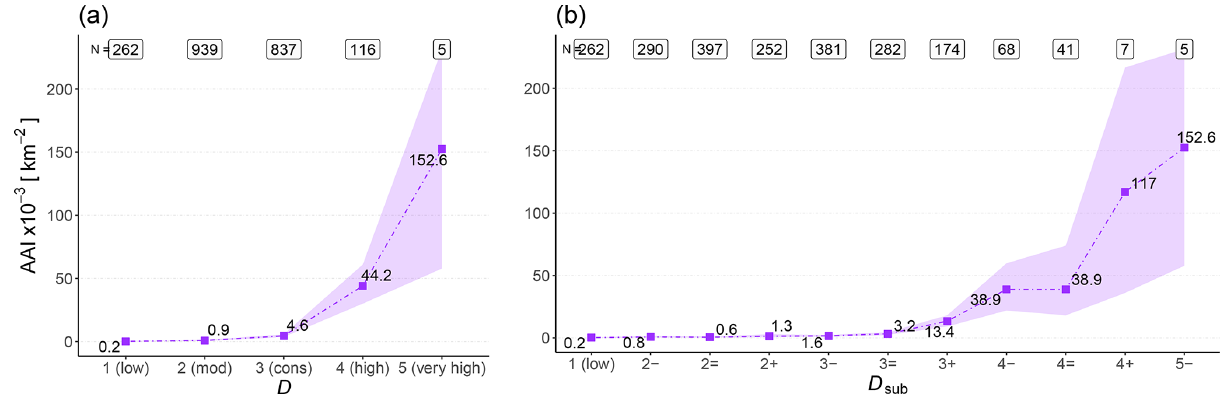
Figure 6. Avalanche activity index (AAI) for natural avalanches per 1000km 2 potential release area ( A PRA ) for (a) each danger level and (b) each sub-level. N represents the number of cases. Shown are the median values (points) and the 95% confidence interval (shaded